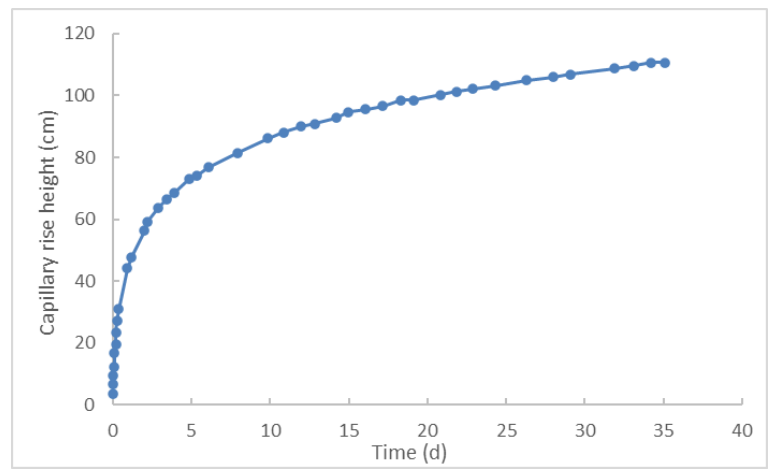
Figure 7. Accumulation curve of capillary height in the sandy loam.